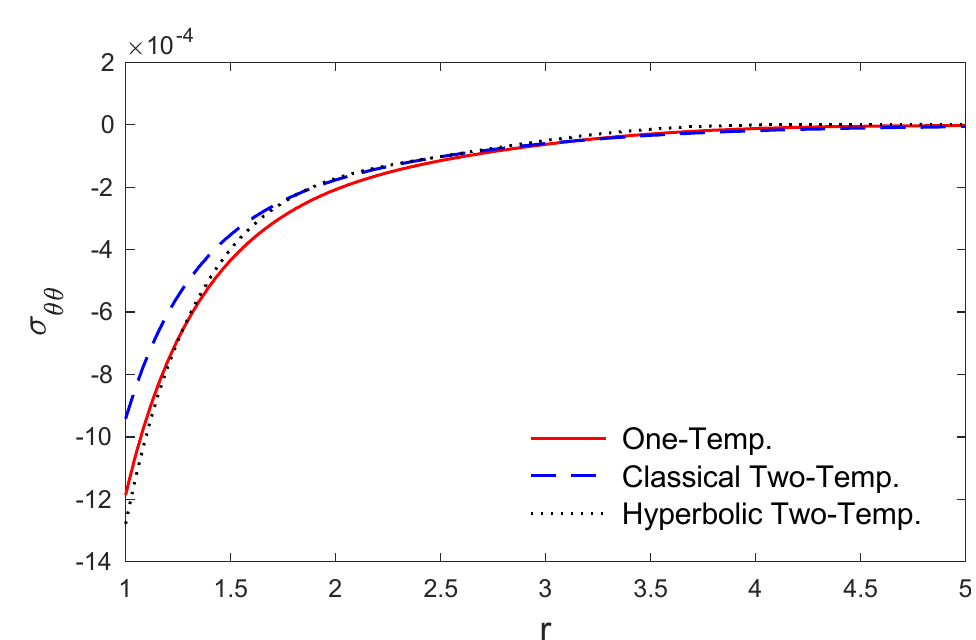
Figure 6. The variation of hoop stress with distance for different models.